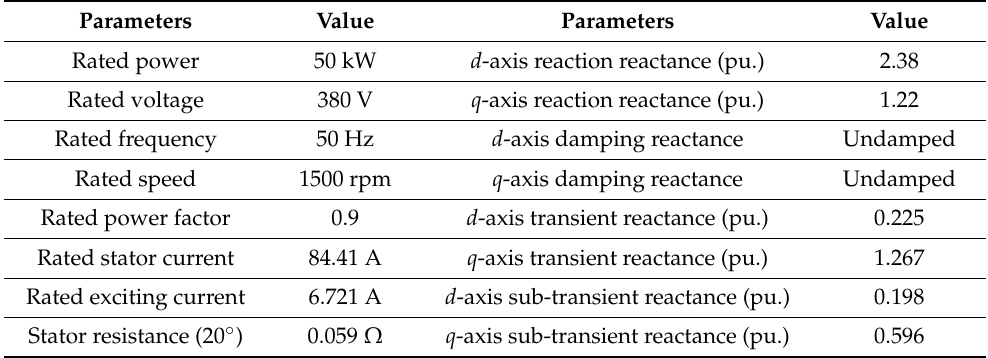
Table 1. The average tour length, gap percentage and average solution time of